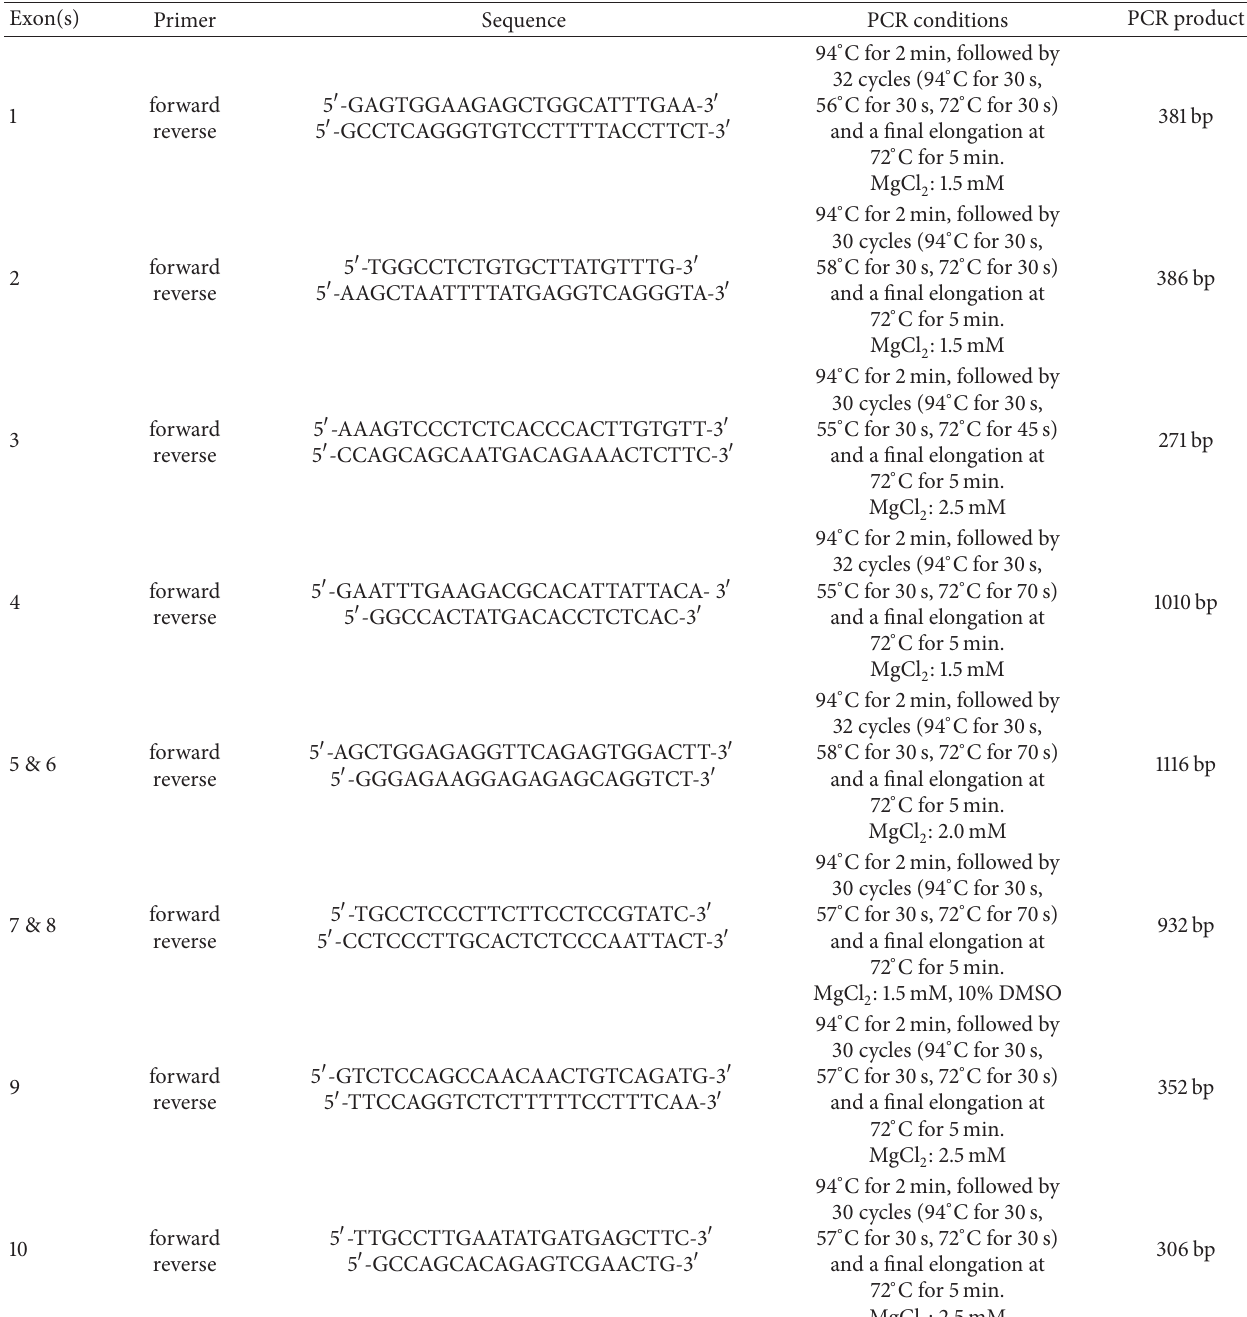
Table 1: Primers and PCR conditions used for the detection of MVK